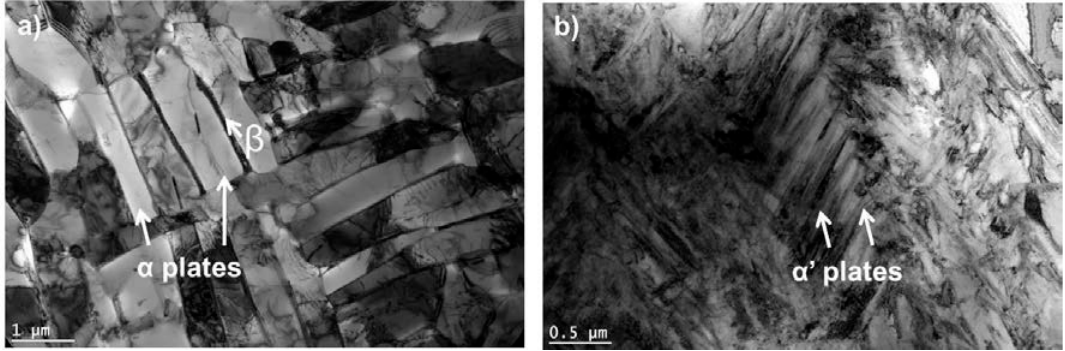
Figure 8. TEM micrographs of EBM ( a ) and SLM ( b ) fabricated material.